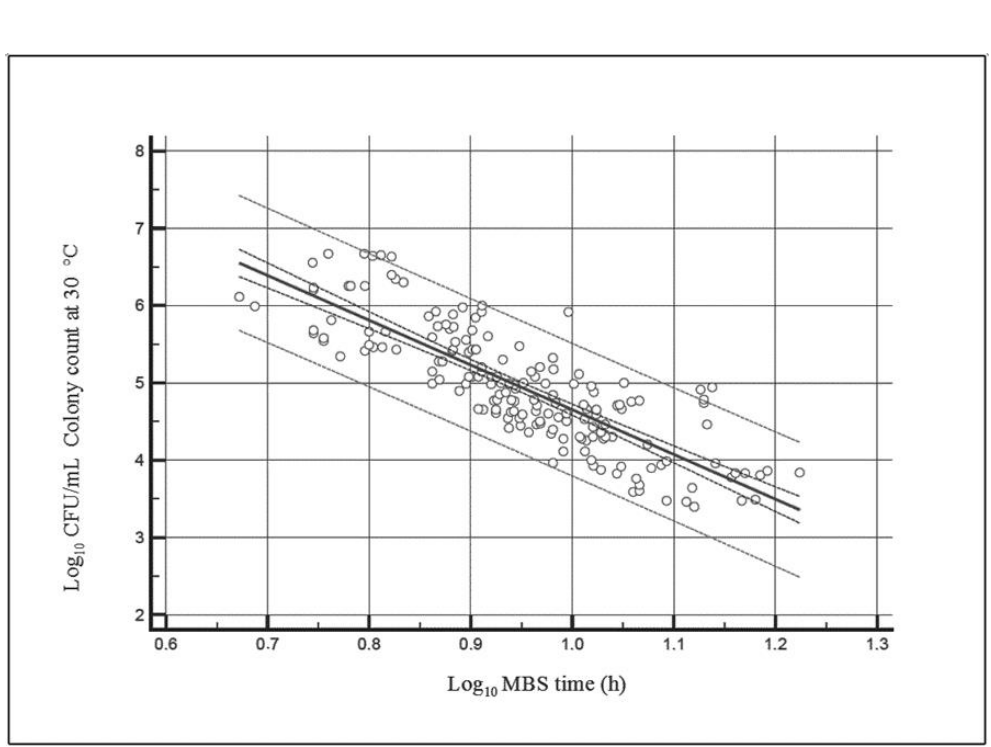
Figure 1. Regression line (R 2 = 0.69) obtained plotting the decimal logarithms of the bacterial concentration values yielded with the reference method (Log CFU/mL) and the decimal logarithm of the time required for Micro Biological Survey (MBS) vials color change yielded with the MBS method (Log h).